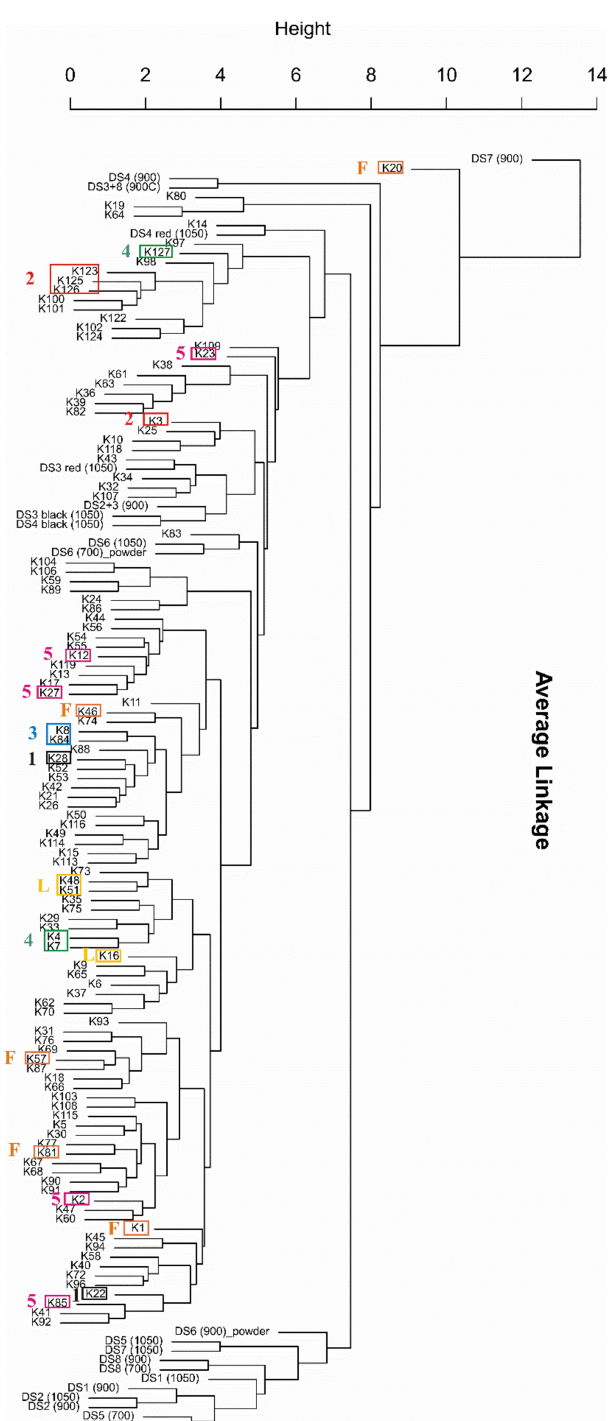
Figure 17. Dendrogram (average linkage agglomerative hierarchical clustering) of chemical analyses presented in Liritzis et al. (2020a). Clustering is based upon the chemical results presented in Liritzis et al., 2020a, in order to be coherent and facilitate distribution of present groupings). Rectangles represent petrographic groups: black—group 1; red—group 2; blue—group 3; green—group 4; magenta—group 5; orange—fine fabric;